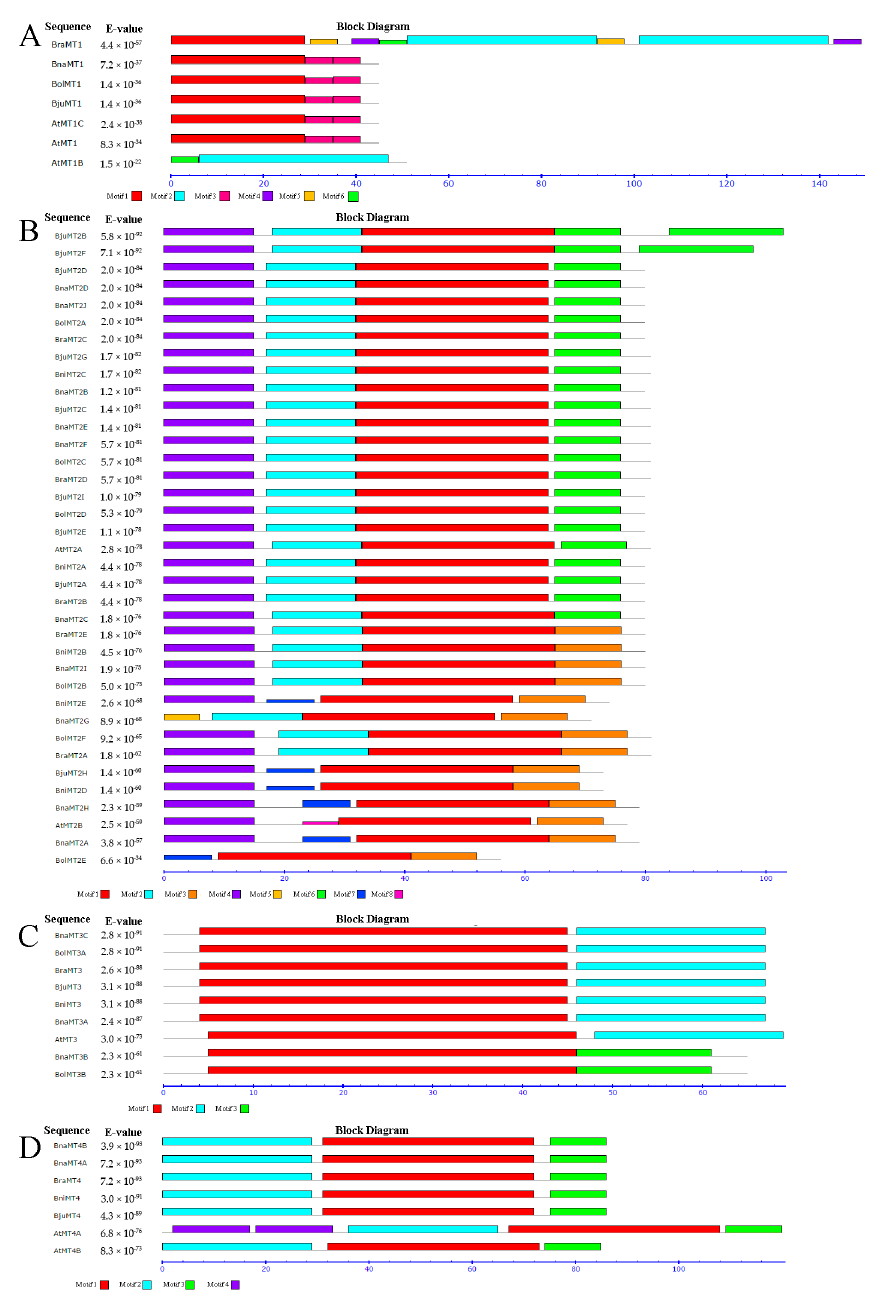
Figure 4. Putative conserved motifs in MT family proteins in various Brassica species identified using the MEME search tool. ( A ) the conserved motifs in MT1 family; ( B ) the conserved motifs in MT2 family; ( C ) the conserved motifs in MT3 family; ( D ) the conserved motifs in MT4 family. Different motifs are represented by different colors, and protein names and combined p values are shown on left side of this figure. The best possible matched motifs, their functional annotation, and motif width are shown in Figure S1.